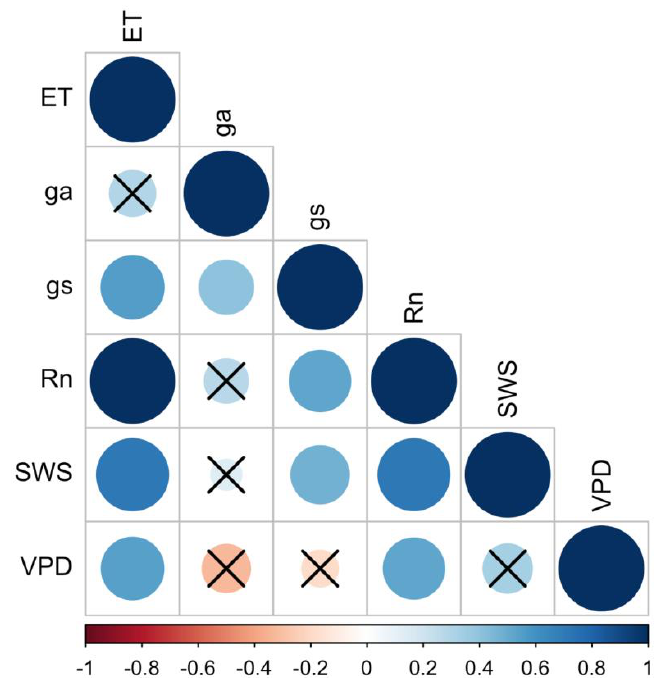
Figure 8. Pearson correlation coefficients among monthly averaged of daily evapotranspiration (ET), bulk surface conductance (g s ), aerodynamic conductance (g a ), net radiation (R n ), vapor pressure deficit (VPD), soil water storage (SWS) for the 2013–2019 period in the seasonally dry Atlantic Forest (SDAF). Insignificant coefficients ( p > 0.05) are marked with an “X”. Dataset used in the statistical modeling. Table 2. Generalized linear model (global model) of monthly daily average evapotranspiration (ET) against the explanatory variables period, bulk surface conductance (g s ), aerodynamic conductance (g a ), net radiation (R n ), vapor pressure deficit (VPD), and soil water storage (SWS) for the 2013–2019 period in the seasonally dry Atlantic Forest (SDAF). Estimate: Variable coefficient, ( . . . ); significance: 0 = ‘***’; 0.01 = ‘*’. Estimate Std.